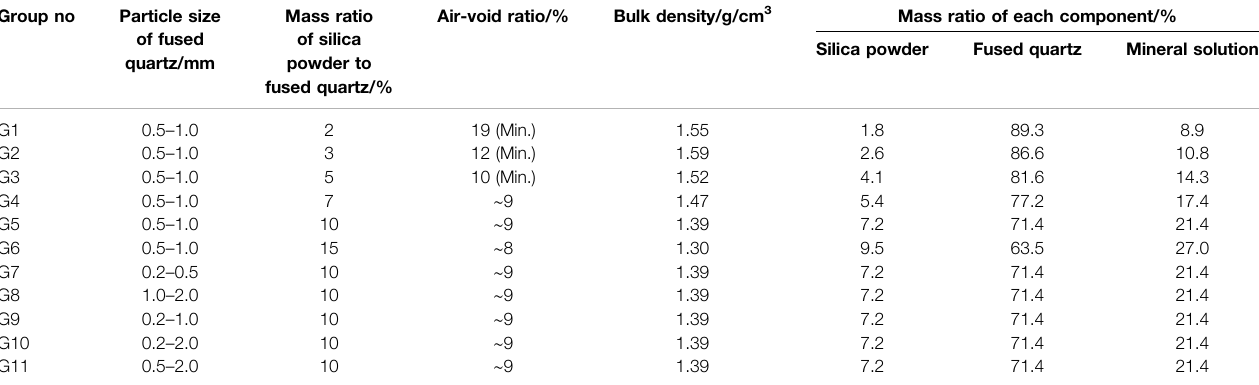
TABLE 1 | Summary of test groups and